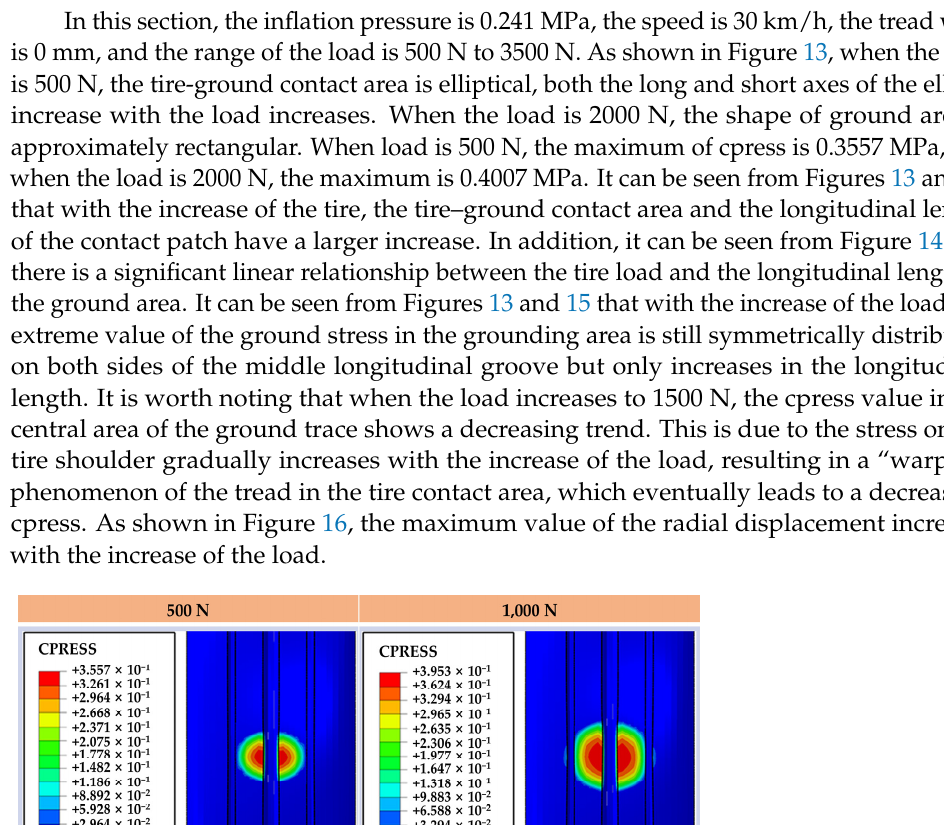
Figure 12. Variation curve of radial displacement under different inflation pressures.